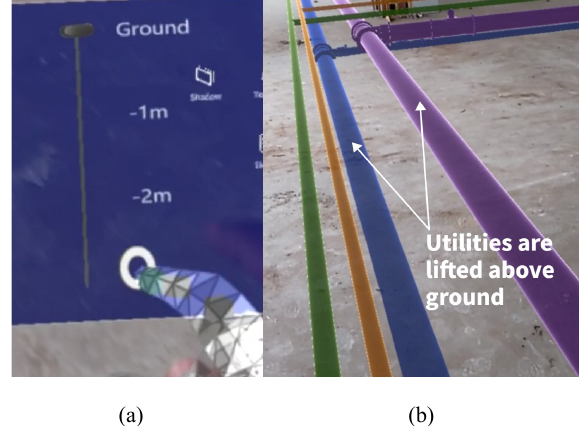
Figure 9. General View